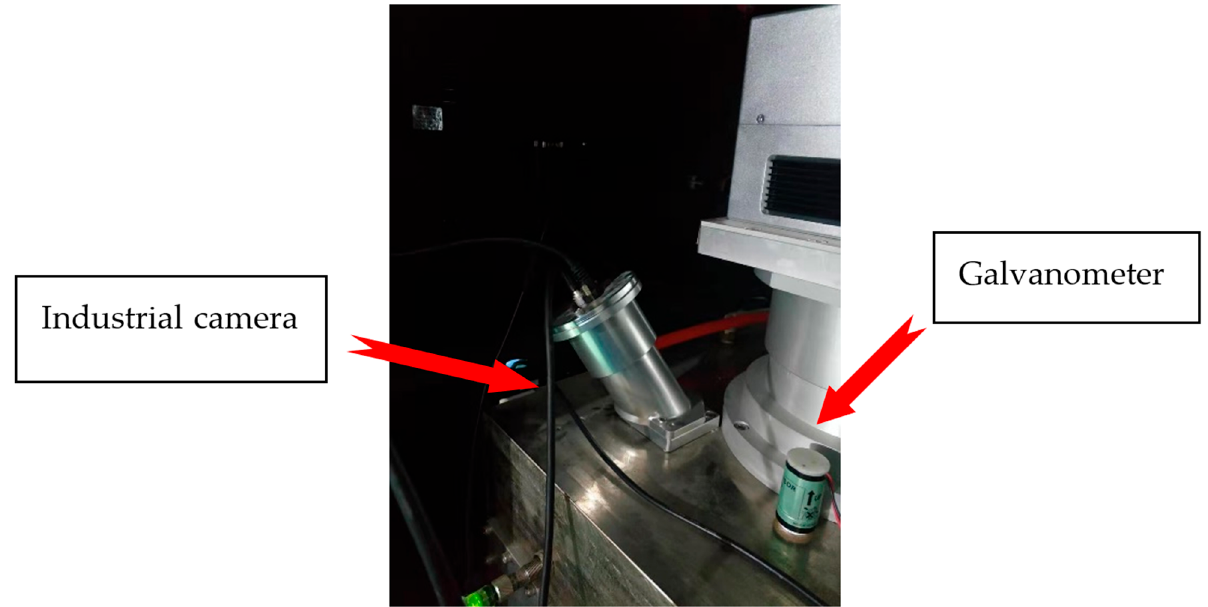
Figure 1. Industrial camera installation location.